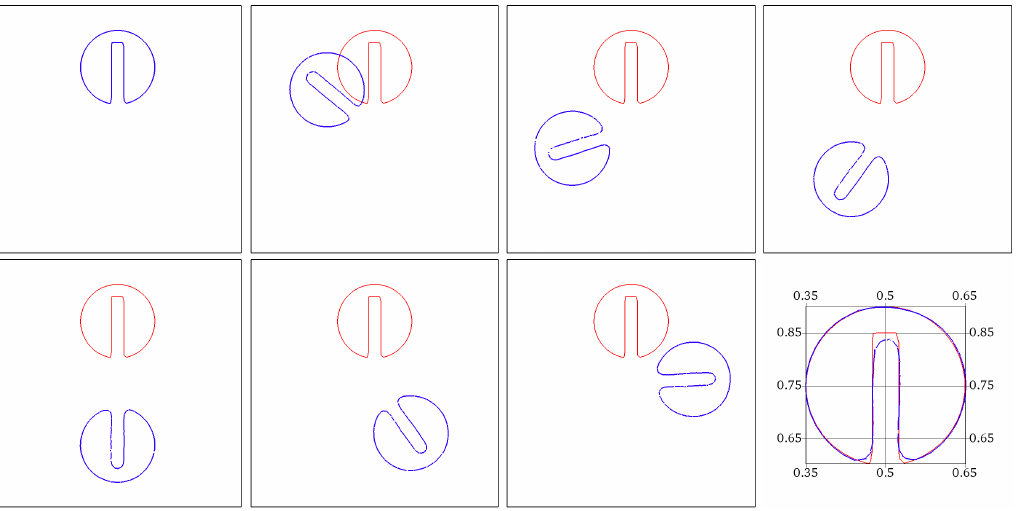
Figure 5. Zalesak test case. Snapshots showing the rotation of the slotted disk at successive times t = 0,1.76,3.77,5.03,2.28,7.54,9.55,4 π . The shape (blue color) obtained is compared to the exact solution after a complete rotation period (red color).